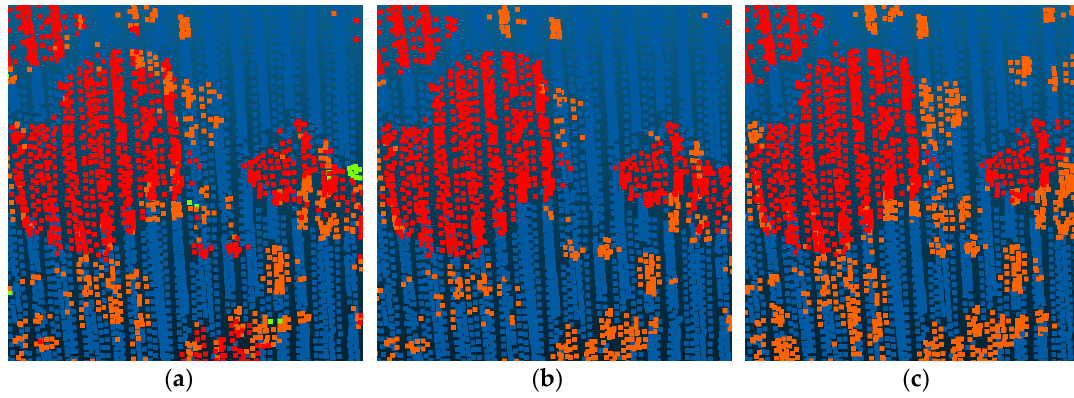
Figure 11. The failed shrub and tree classification. ( a ) The Point_S result. ( b ) The SegT_M result. ( c ) The ground truth.